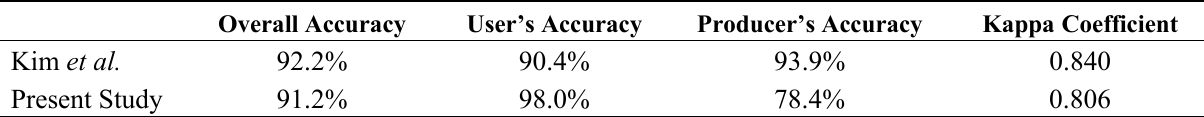
Table 3. Comparison of error matrices of Kim et al. with the present study. The Producer’s Accuracy refers to the accuracy of the analytical procedure and the User’s Accuracy refers to the reliability of the analytical